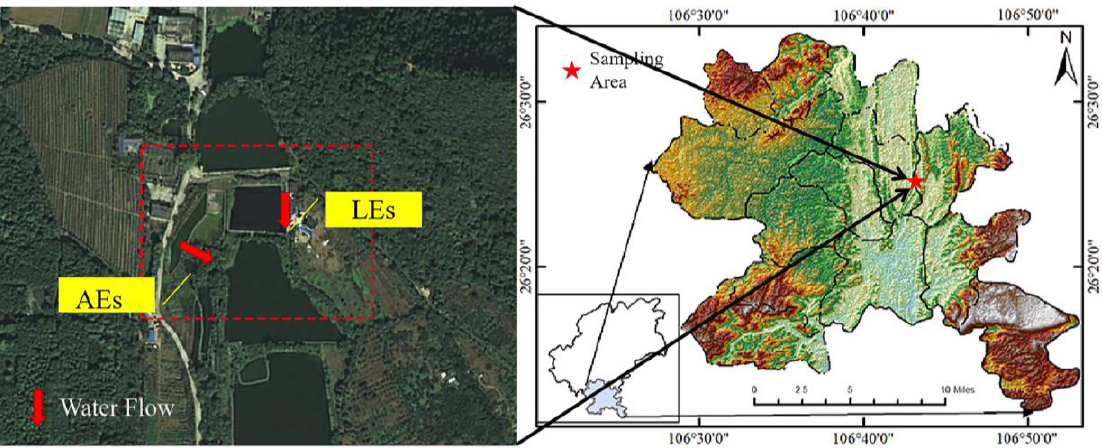
Figure 1. Location map of the study area and water sampling sites in the educational laboratory base of Guizhou University.